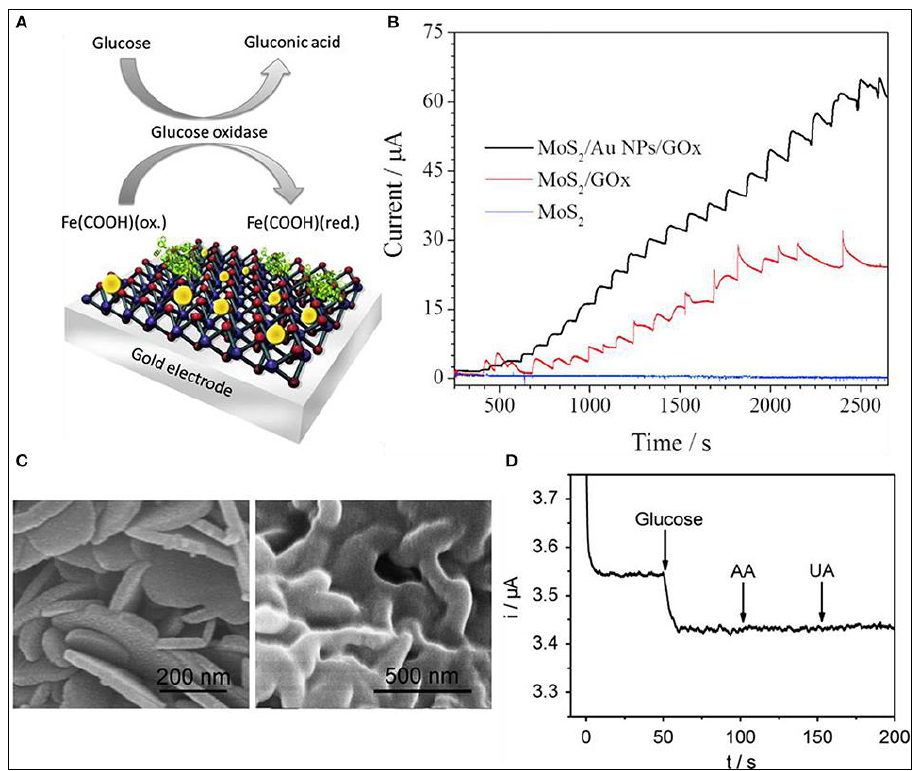
Figure 5. Glucose sensors using transition metal dichalcogenides. ( A ) Illustration for basic glucose sensor using Au nanoparticle decorated MoS 2 . ( B ) Response comparison between pristine MoS 2 , MoS 2 /GOx, and MoS 2 /Au NP/GOx electrodes. Reprinted with permission from Ref. [48]. 2017, Elsevier. ( C ) Scanning electron microscope images of pristine SnS 2 ( left ) and GOx/MWCNTs – SnS 2 ( right ). ( D ) Response curves of glucose having selectivity at GOx/MWCNTs – SnS 2 . Figures ( C , D ) were (Reproduced from [50]. 2014, Elsevier).